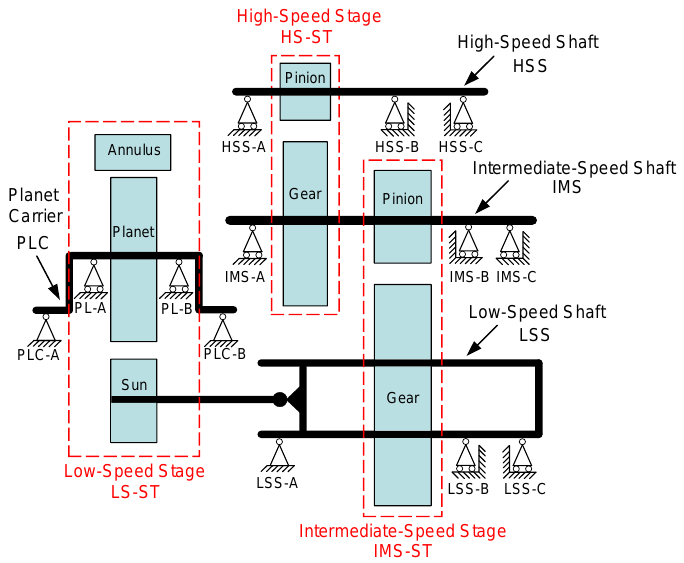
Figure 3. Gearbox internal layout and nomenclature abbreviations.